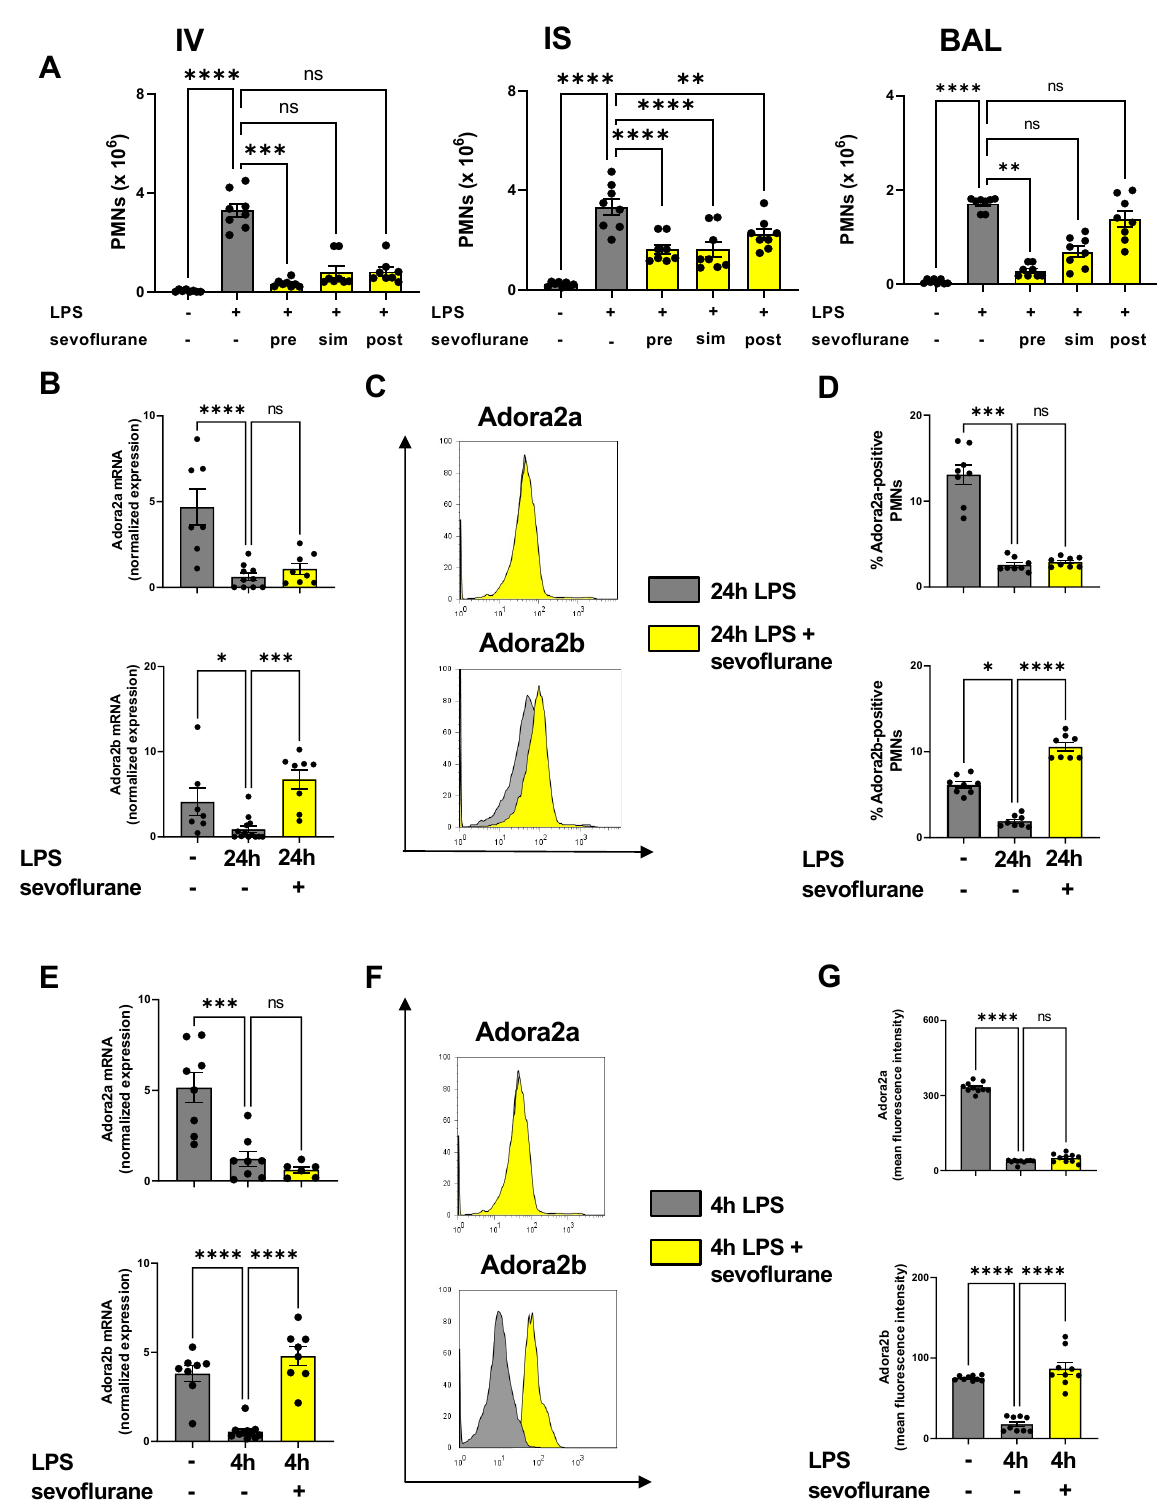
Figure 1. Time-dependency of the anti-inflammatory effects of sevoflurane on PMN migration and the influence of sevoflurane on the expression of adenosine receptors. Sevoflurane was applied one hour before (pre) LPS inhalation, immediately after LPS (sim), or three hours (post) after LPS stimulation. ( A ) Polymorphonuclear neutrophil (PMN) sequestration into the intravascular space (IV), interstitium (IS), and bronchoalveolar lavage (BAL) was assessed in wild-type animals by flow cytometry ( n = 6–8). ( B ) The gene expression of the adenosine receptors A2A (Adora2a) and A2B (Adora2b) in the